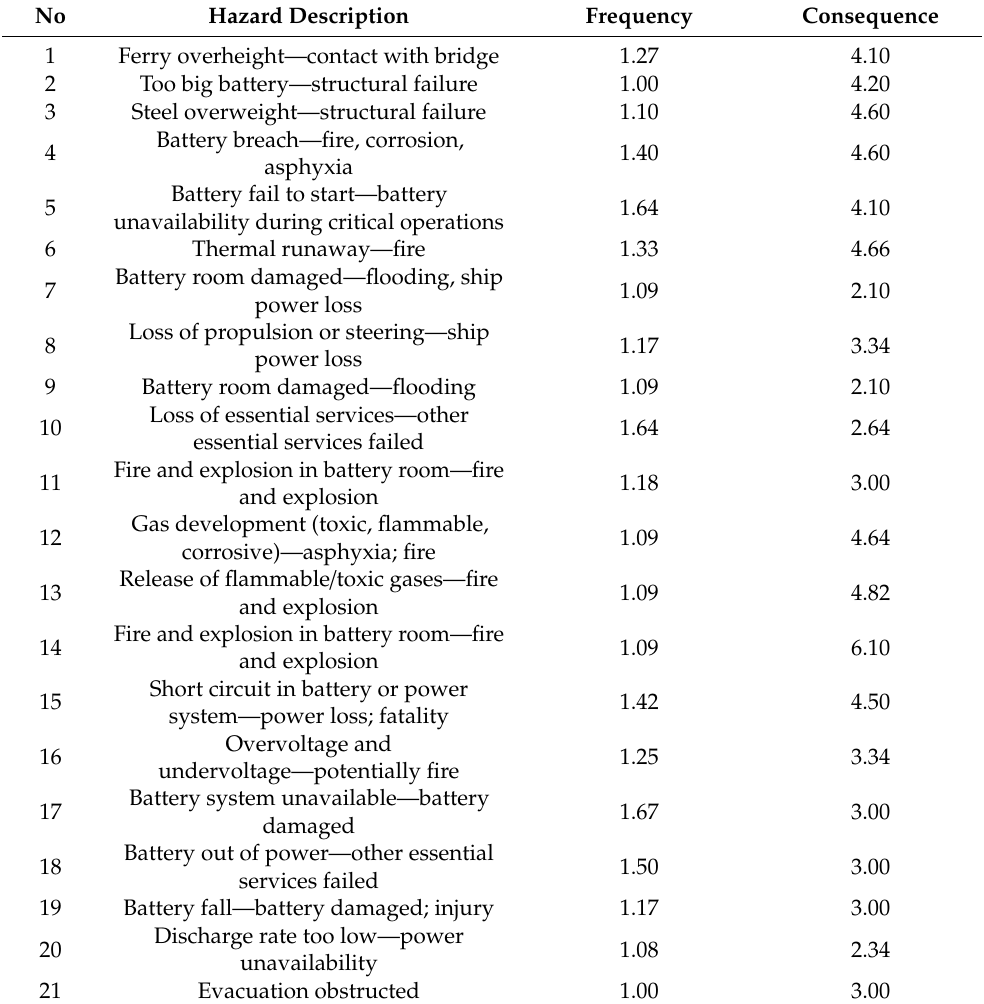
Figure 9. Fault tree analysis on hazard associate with grounding. Table 5. HAZID questionnaire results—design, construction and